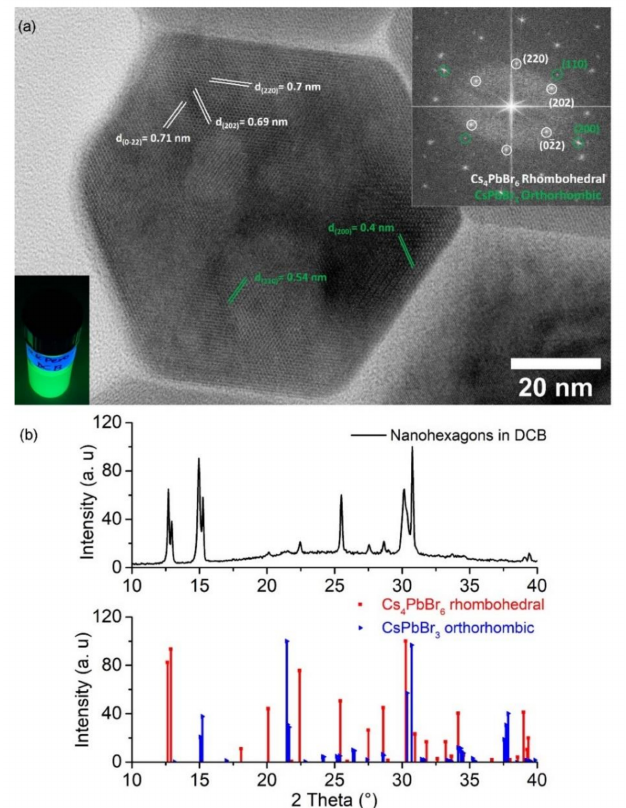
Figure 2. ( a ) High resolution TEM (HRTEM) image of the all-inorganic metal halide nanohexagons dispersed in dichlorobenzene. Insets: The fast Fourier transform (FFT) pattern of the HRTEM image of the individual nanohexagon (upper image) and colloidal solution photograph (under UV illumination, λ = 365 nm) (bottom image); ( b ) XRD pattern of the same sample. The reference patterns of the rhombohedral Cs 4 PbBr 6 crystal structure (ICSD-025124) and the orthorhombic (ICSD-97851) are also provided for comparison (red and blue pattern in